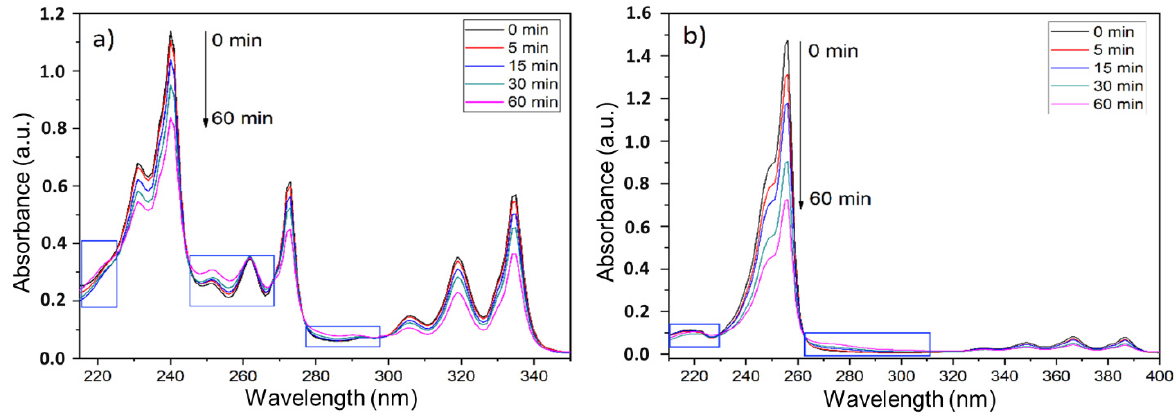
Figure 4. UV-Vis absorption spectra of the samples extracted from the PPC fragments with ( a ) pyrene and ( b ) 9-methylanthracene, after different ozonation times.